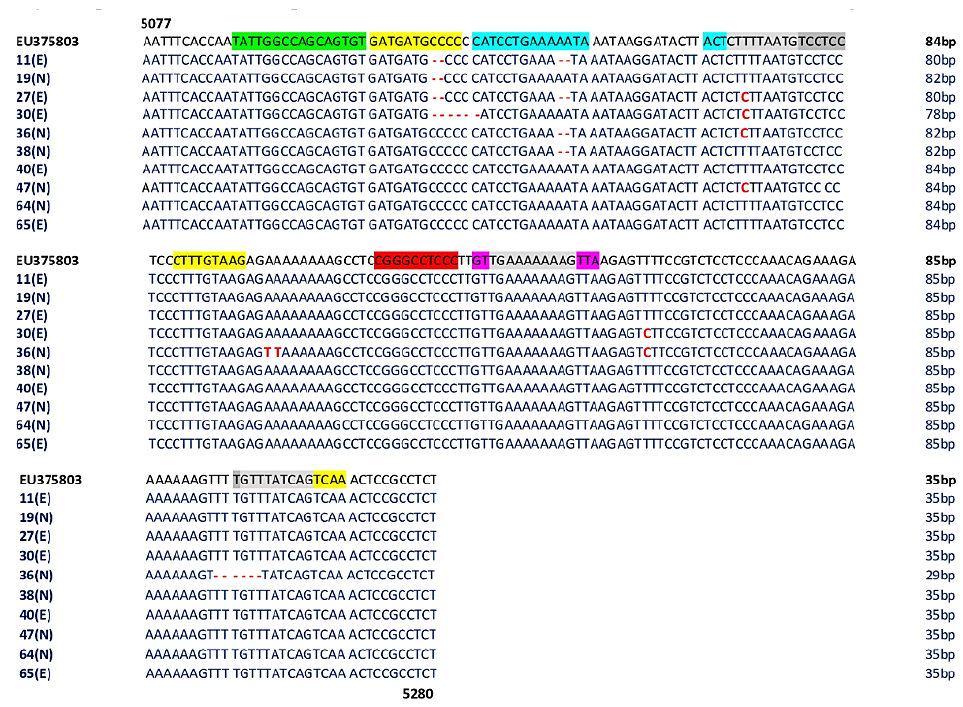
Figure 1. Schematic representation of the MCPyV genome (strain MCC350). The double-stranded DNA genome is 5387 bp in length. The early region encodes the large T antigen (LT), small T antigen (sT), 57 kT antigen (57 kT) and ALTO (alternate frame of the large T open reading frame). These genes function to allow for viral DNA replication. The late region is transcribed in the opposite direction and encodes the structural components of the virus capsid: virus protein 1 (VP1) and the minor capsid proteins virus protein 2 (VP2). MCPyV does not seem to express virus protein 3 (VP3), and virions do not seem to contain VP3, despite an in-frame internal ATG start codon in the VP2 gene. At the top of the figure, the amplified noncoding control region (NCCR) of 203 base pair (bp) (5077 – 5280 bp). Putative binding sites for cellular transcription factors are highlighted in different colors as follows: